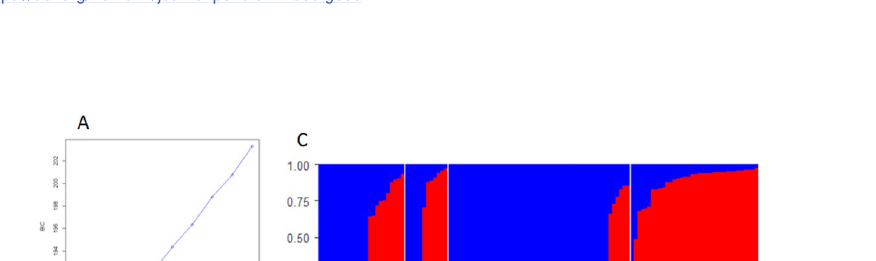
Fig 6. PCoAs of the 10 DeerPlex (DP), 10 DP plus 10 X-, 10 DP plus 5 Y-chromosomal and 10 DP plus 15 sex- chromosomal (i.e. combined 10 X plus 5 Y) microsatellites (STRs). Note: Combining autosomal markers with markers of the two sex chromosomes improved the discriminatory power (i.e. 1 st columns versus 4 th columns). Samples from NE Hungary are in red, SW samples in blue. SW, samples SWG, SW1, SW2 combined when compared with NE; SWG and SW1 +SW2 compared with NE separately. Note the high similarity for the SW subsets (2 nd and 3 rd row).